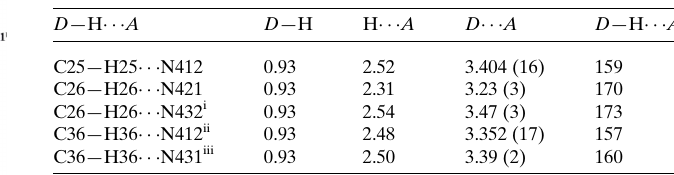
Table 1 Hydrogen-bond geometry (A˚ , (cid:5) ).